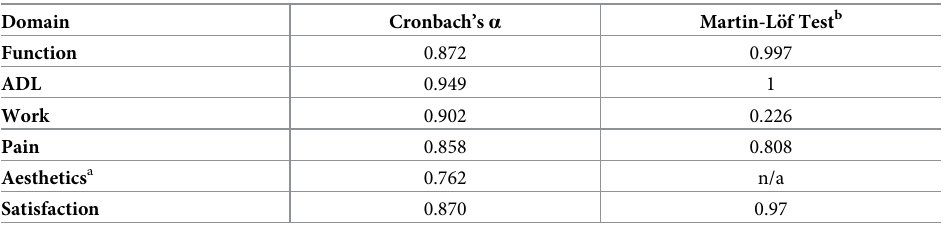
Table 4. Overall domain